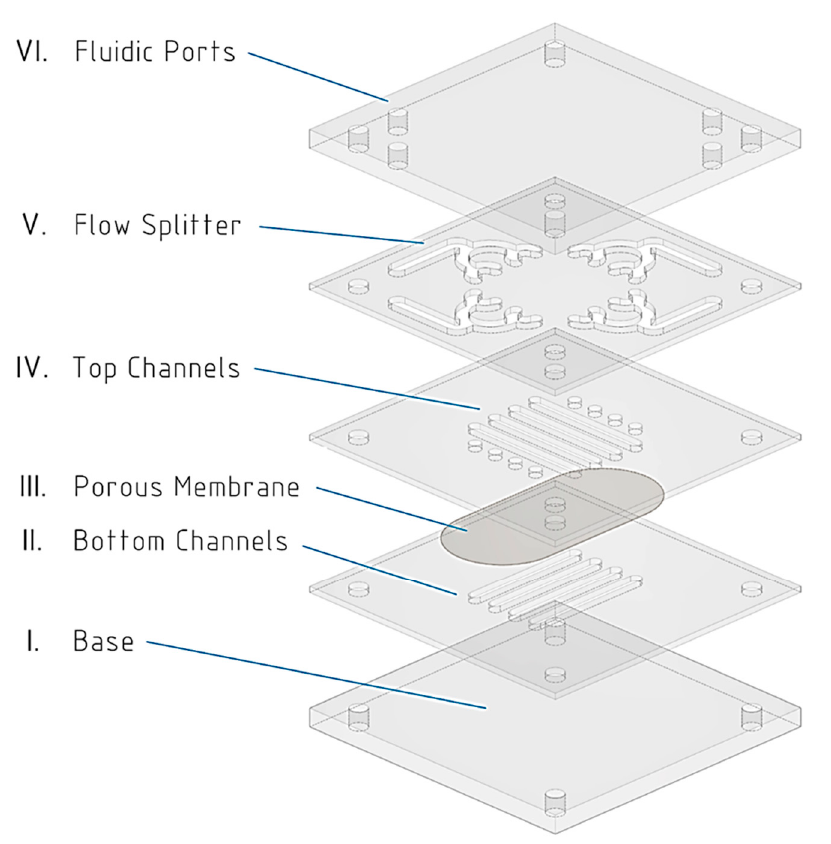
Figure 1. Cyclic Olefin Polymer (COP) device exploded view. From bottom to top: (I) base layer (COP); (II) lower channels layer (COP); (III) Poly-Carbonate (PC) porous membrane; (IV) upper channels layer (COP); (V) flow splitters (COP); (VI) inlets/outlets layer (COP/Poly-Methyl-MethAcrylate (PMMA)).